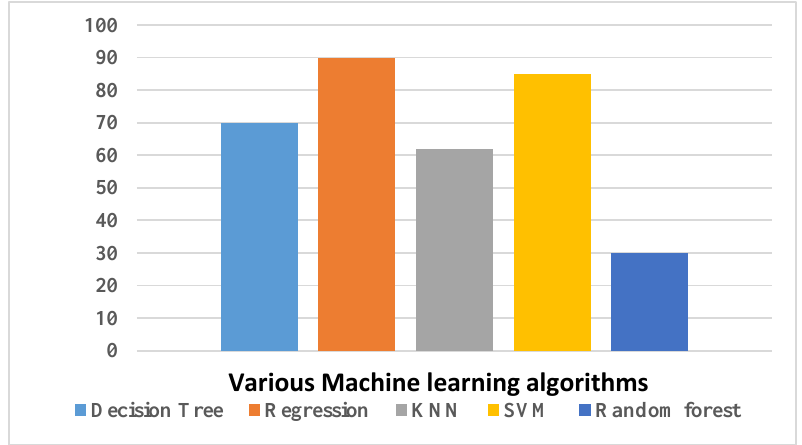
Figure 20. Comparisons of the overall accuracy of different ML algorithms.